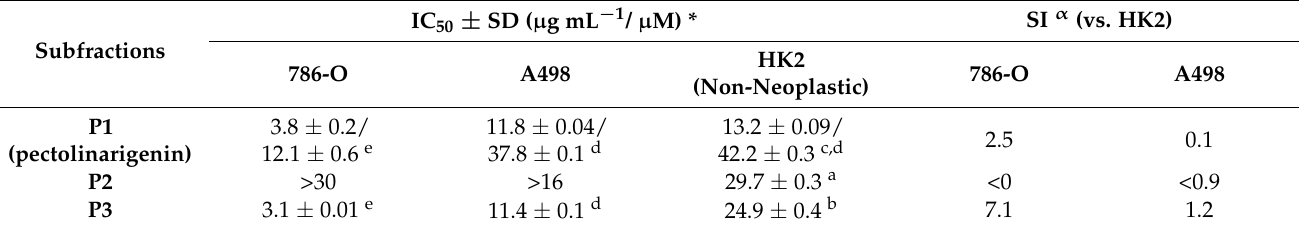
Table 3. The IC 50 values and respective selectivity indexes of subfractions P1 , P2 and P3 isolated from the G18.EE-EtOAc fraction against RCC cells (72 h treatment).